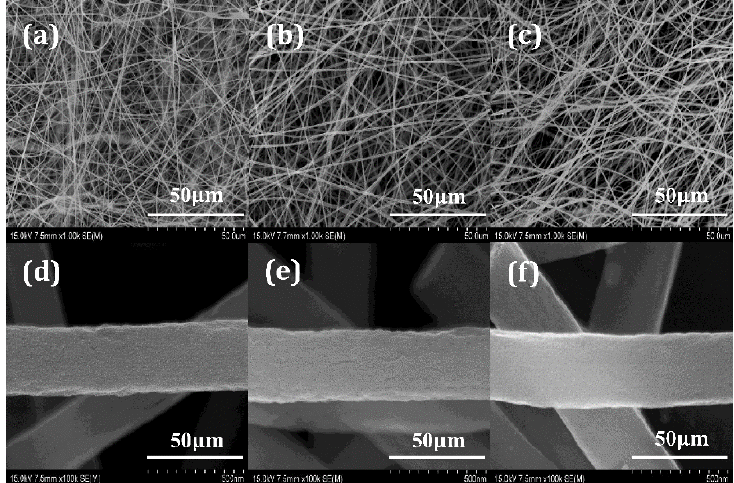
Figure 1. FE-SEM images of ( a ) electrospun polyacrylonitrile (PAN)-based nanofibers (NF), ( b ) 10 at.% Figure 1. FE‐SEM images of ( a ) electrospun polyacrylonitrile (PAN)‐based nanofibers (NF), ( b ) 10 Mn-embedded PAN nanofiber (NF-Mn1), ( c ) 40 at.% Mn-embedded PAN nanofibers (NF-Mn2), at.% Mn‐embedded PAN nanofiber (NF‐Mn1), ( c ) 40 at.% Mn‐embedded PAN nanofibers (NF‐Mn2), ( d ) PAN-based carbon nanofiber (CN), ( e ) 10 at.% Mn-embedded carbon nanofibers (CN-Mn1) ( d ) PAN‐based carbon nanofiber (CN), ( e ) 10 at.% Mn‐embedded carbon nanofibers (CN‐Mn1) and ( f ) 40 at.% Mn‐embedded carbon nanofibers (CN‐Mn2).